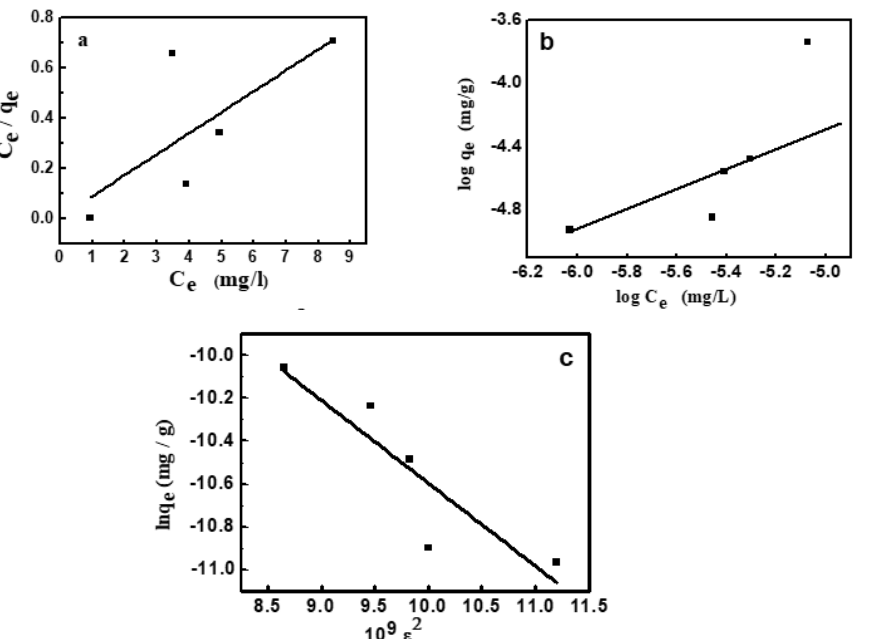
Figure 7. Adsorption isotherms for adsorption of MV2B onto NiO/PDA, ( a ) Langmuir, ( b ) Freun- dlich, ( c ) Dubinin–Radushkevich.